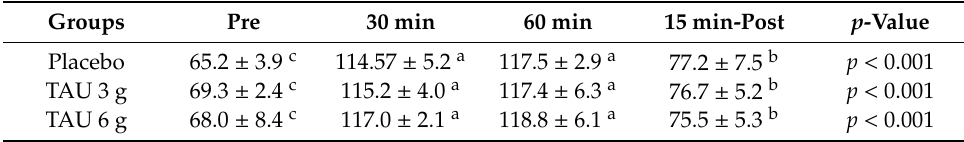
Table 3. Heart rate (bpm / min) measures during exercise